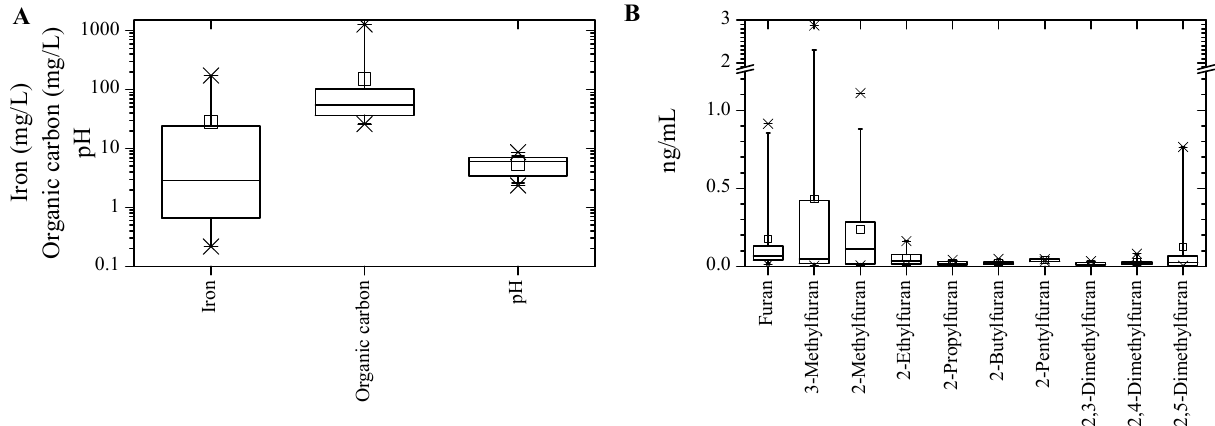
Figure 8. Distribution of (A) iron and organic carbon concentration as well as pH and (B) of the furan emissions from the various Australian and Dead Sea water samples. Only the Australian water samples were analysed for organic